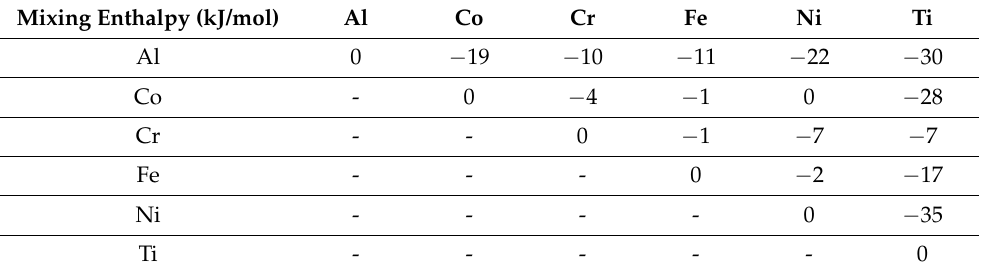
Table 3. Mixing enthalpy between AlCoCrFeNiTi. Mixing Enthalpy (kJ/mol)